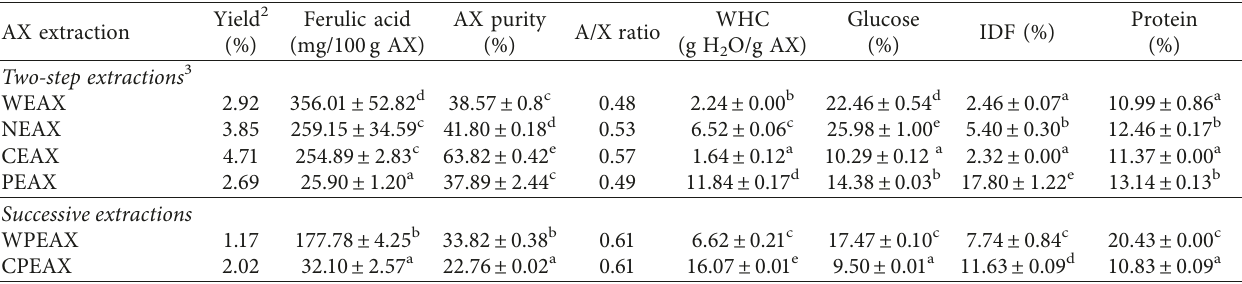
Figure 1: Solvent and enzymatic arabinoxylan extraction from rye bran. (a) Two-step extraction. (b) Successive extraction. Adapted from Bender et al. Table 1: Physicochemical properties of differently extracted AXs and their respective extraction yield 1 .